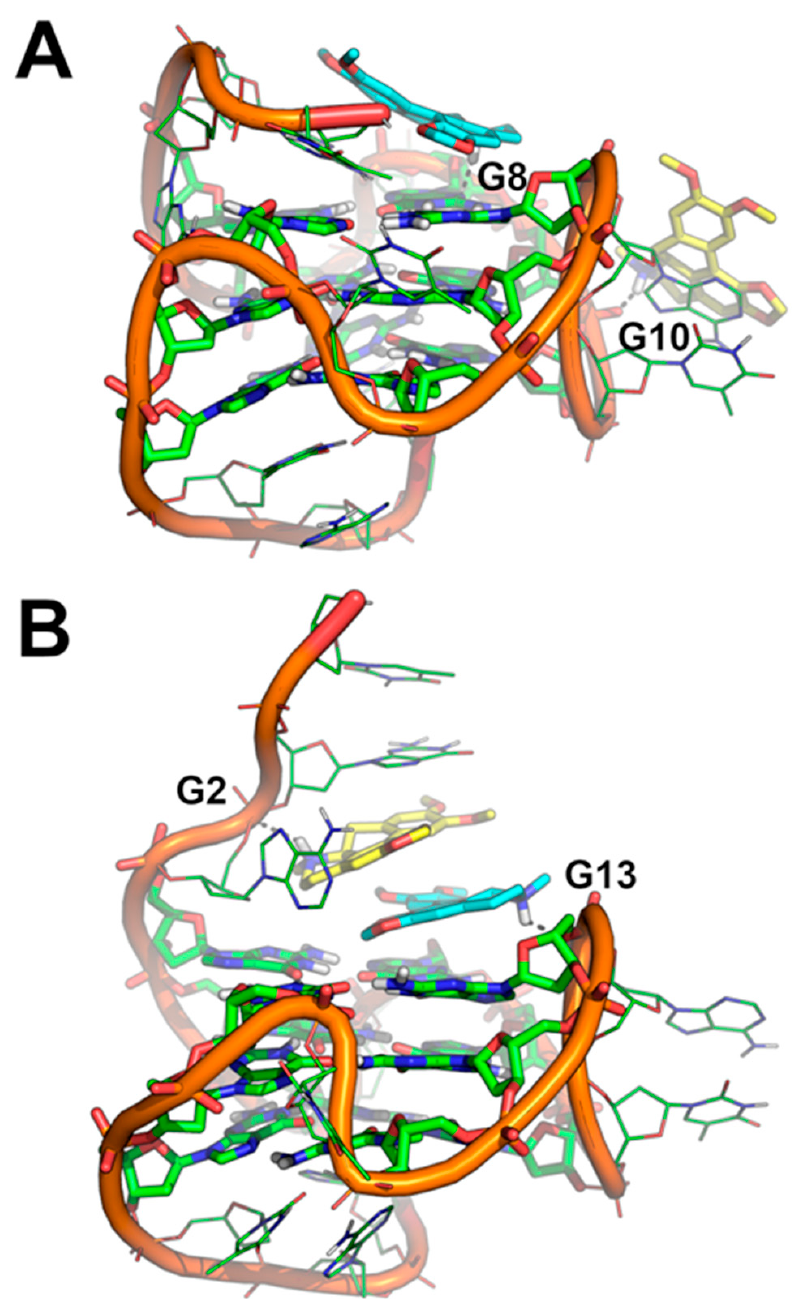
Figure 8. ( A , B ) Binding mode of two molecules of Dicentrine to the Pu22 G-quadruplex investigated using two independent replicas of MD simulations. The representative frame extracted by the MD trajectories through cluster analysis is shown. Pu22 is represented as green cartoon and lines; residues forming the G-tetrads are shown as sticks. Dicentrine #1 and Dicentrine #2 are shown as sticks and colored cyan and yellow, respectively. Polar contacts are highlighted by black dashed lines; nucleotides involved in polar interactions with Dicentrine are labeled.